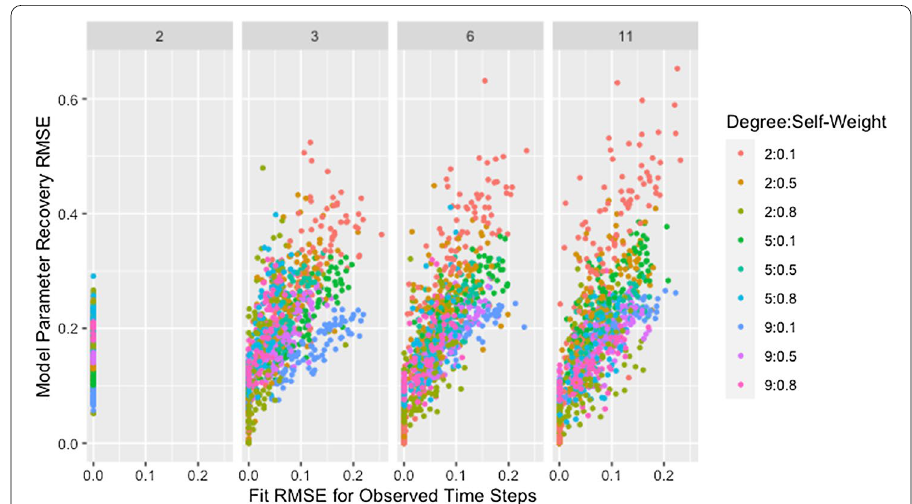
Fig. 11 RMSE for model parameter recovery by fit RMSE, degree, self-weight, and time steps. RMSE for known and predicted weights by RMSE for observed and predicted opinions on observed time steps, target degree, target self-weight, and number of time steps across panels